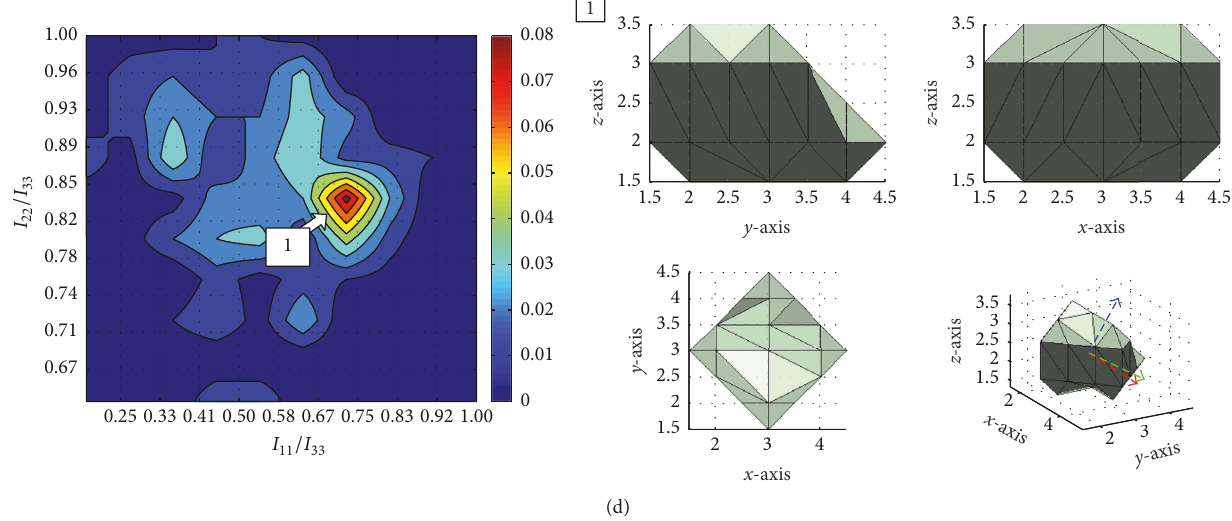
Figure 4: Contour maps of 𝐼 11 /𝐼 33 and 𝐼 22 /𝐼 33 ratios of the FASF sample and representative pore shapes in areas 1 ∼ 3: (a) micropore volume ≥ 10 −2 mm 3 , (b) micropore volume 10 −3 ∼10 −2 mm 3 , (c) micropore volume 10 −4 ∼10 −3 mm 3 , and (d) micropore volume < 10 −4 mm 3 .